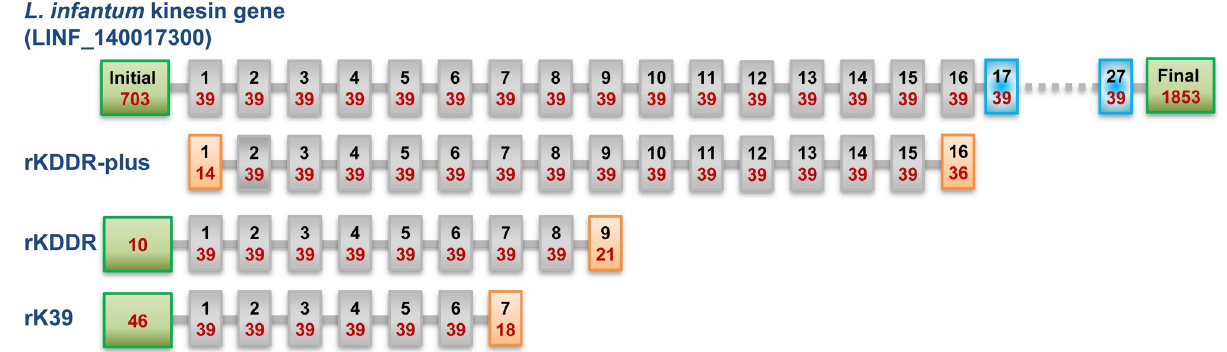
Fig 1. Comparison of the structure of the rKDDR-plus and other antigens based on the kinesin protein of L . infantum . The kinesin-derived proteins used in the comparison were rKDDR-plus, rKDDR [26], and rK39 [23]. The red numbers represent the amount of amino acids present in each block and the black numbers indicate the position of the block. The green blocks represent the non-repetitive portion of amino acids present in the kinesin proteins. The gray blocks represent the repetitive motif units of 39 amino acids present in each protein. The blue blocks indicate repetitive blocks present in the kinesin protein, but which have variations of certain amino acids in relation to the consensus sequence of 39 amino acids described by Burns et al. [23]. The orange blocks represent the incomplete repetitive motif units of amino acids.